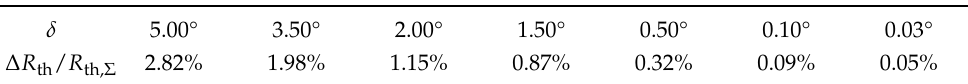
Table 2. Deviation in thermal impedance Z th ( t → ∞ ) averaged for structure 1 to 3 at various δ .